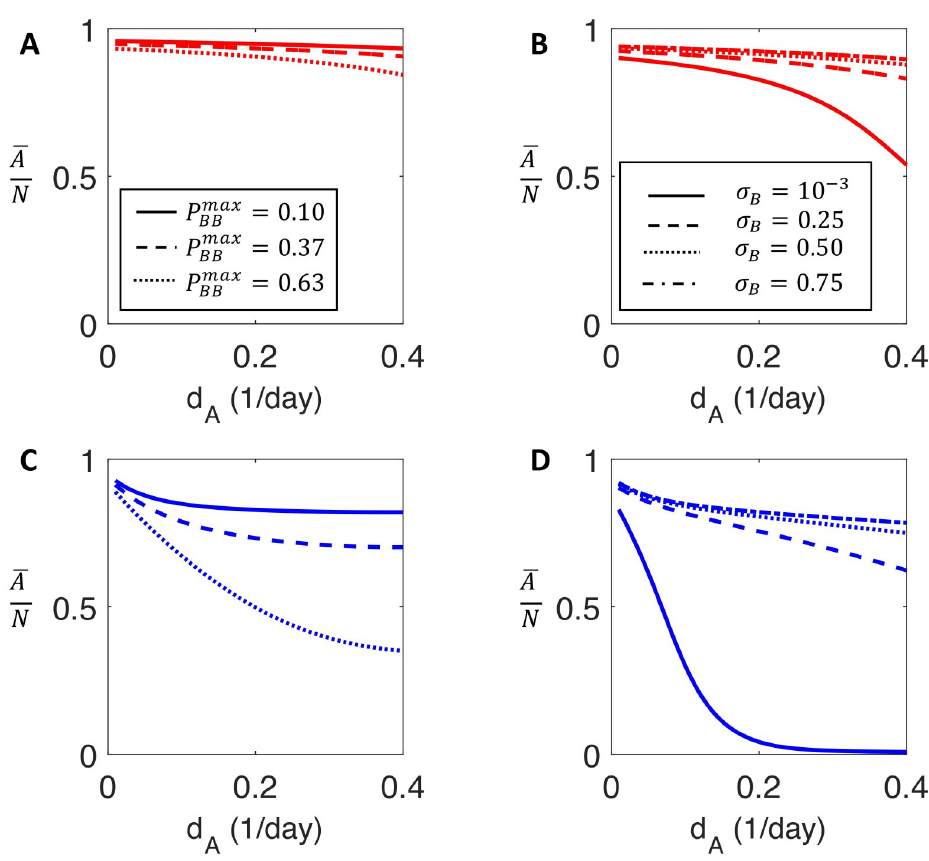
Fig 3. The proportion of drug-sensitive cells for increasing values of the sensitive cell death rate. A and B ) the proportion of the total population that is drug sensitive during Malthusian growth calculated using the stable age distribution detailed in section Stable age distribution and population proportion in S1 Text as a function of increasing sensitive death rate d A . A ) plots the proportion of drug sensitive cells for three values of P max ¼ 0 : 1 ; 0 : 37 ; 0 : 63 . B ) BB presents the proportion of drug sensitive cells for σ = [1 × 10 − 3 , 0.25, 0.5, 0.75]. If drug-tolerant cells are unlikely to B retain tolerant phenotype upon reproduction, then phenotype switching can partially mitigate the effect of increasing death rate of drug sensitive cells. The proportion of drug-tolerant cells in A and B compare favourably with the population composition of drug-tolerant cells reported by Sharma et al. [15]. C and D ) the proportion of drug sensitive cells in the limited-resource setting is obtained by simulating the model (2) for 500 days and computing of drug ¼ 0 : 1 ; 0 : 37 ; 0 : 63 . D ) the model predictions for σ = sensitive cells at day 500. C ) the model predictions for P max B BB [1 × 10 − 3 , 0.25, 0.5, 0.75]. Phenotypic switching is less capable of mitigating increased death in the resource-limited setting. of drug-sensitive cells while holding r constant acts to decrease the fitness of the drug-sensi- A tive cells (Fig 3A and 3B), corresponding to both a decrease in the relative fitness difference between drug-sensitive and drug-tolerant cells and a decrease in the total population fitness. This is independent of the parameters that determine phenotypic inheritance (see section Non- linear eigenproblem for the Malthusian parameter in S1 Text for details). We found that the proportion of sensitive type A cells was consistently higher during unlimited growth than in the resource limited case. This prediction is in line with experimental results where there was a smaller proportion of persister cells during Malthusian growth [20, 39]. Further, the strictly decreasing behaviour of the ratio � A = ð � A þ � B Þ as d increases, so λ decreases while λ remains A A B constant, indicates that the fitness difference between phenotypes plays a critical role in deter- mining population composition during Malthusian growth.